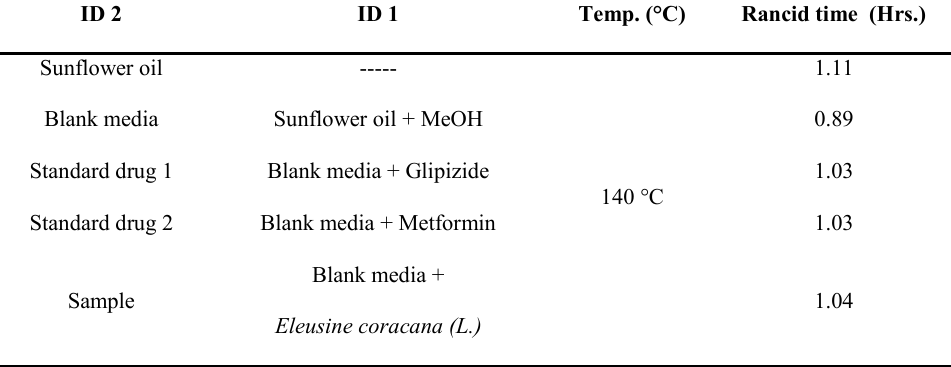
Figure 3. (a) Rate of rancidity of sunflower oil in the presence of methanol; (b) Rate of rancidity of sunflower oil in the presence of methanol and standard drug Glipizide; (c) Rate of rancidity of sunflower oil in the presence of methanol and extracted ingredients of Eleusine coracana (L.). Table 4. Summarized data of Rancidity of sunflower oil in the presence of media, standard drugs and Eleusine coracana (L.) extract. ID 1 Temp. (°C) Rancid time